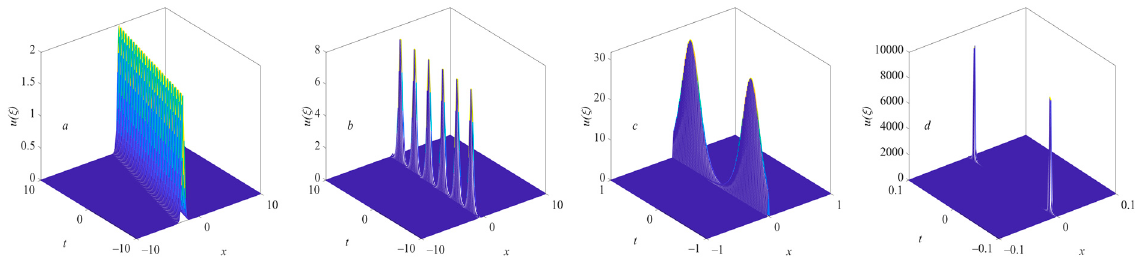
Figure 9. Evolution of solitary waves with n in u 9 n when k = 1: ( a ) n = 1, ( b ) n = 2, ( c ) n = 3,